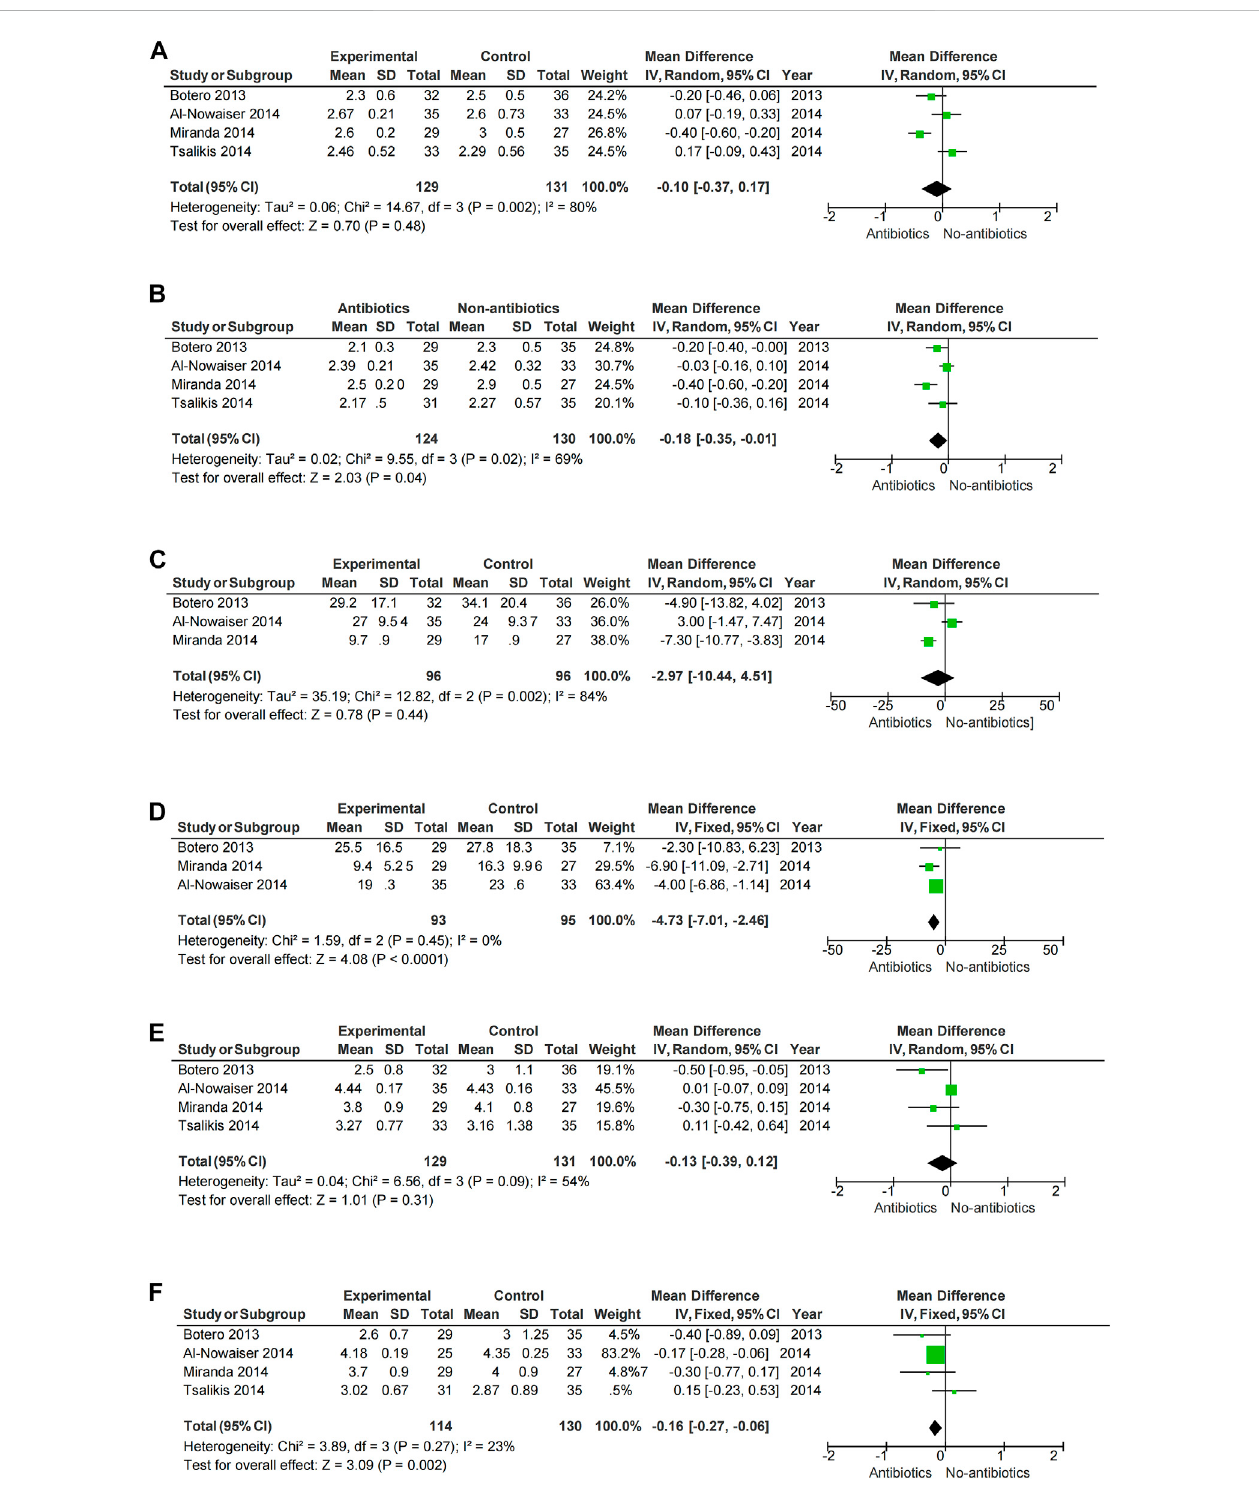
FIGURE 3 Forestplotoftheeffectofsystemicadjuvantantibioticsonperiodontalchanges. (A – B) ChangesinPDat3and6 months. (C – D) ChangesinBOPat3and 6 months. (E – F) Changes in CAL at 3 and 6